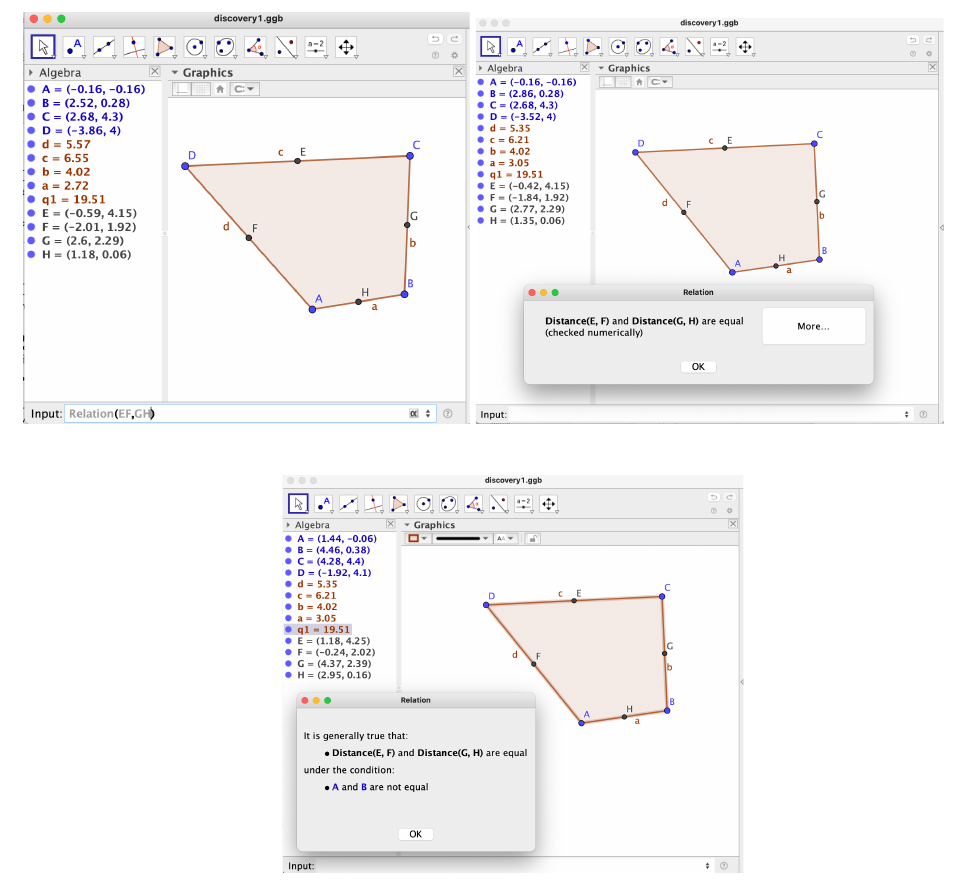
Figure 3. The Relation tool and command.